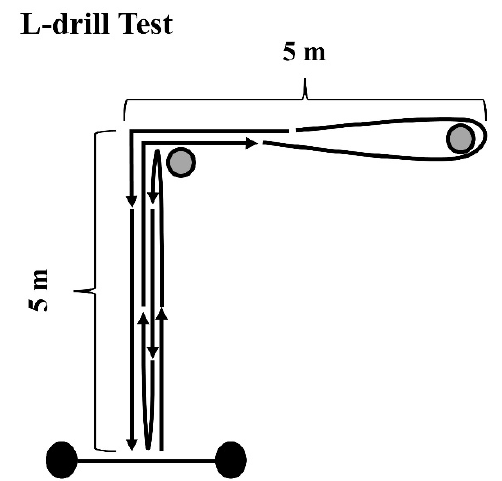
Figure 2. Schematic representation of the L-drill test. Black circles represent the position of the photocells and grey circles the position of the cones.